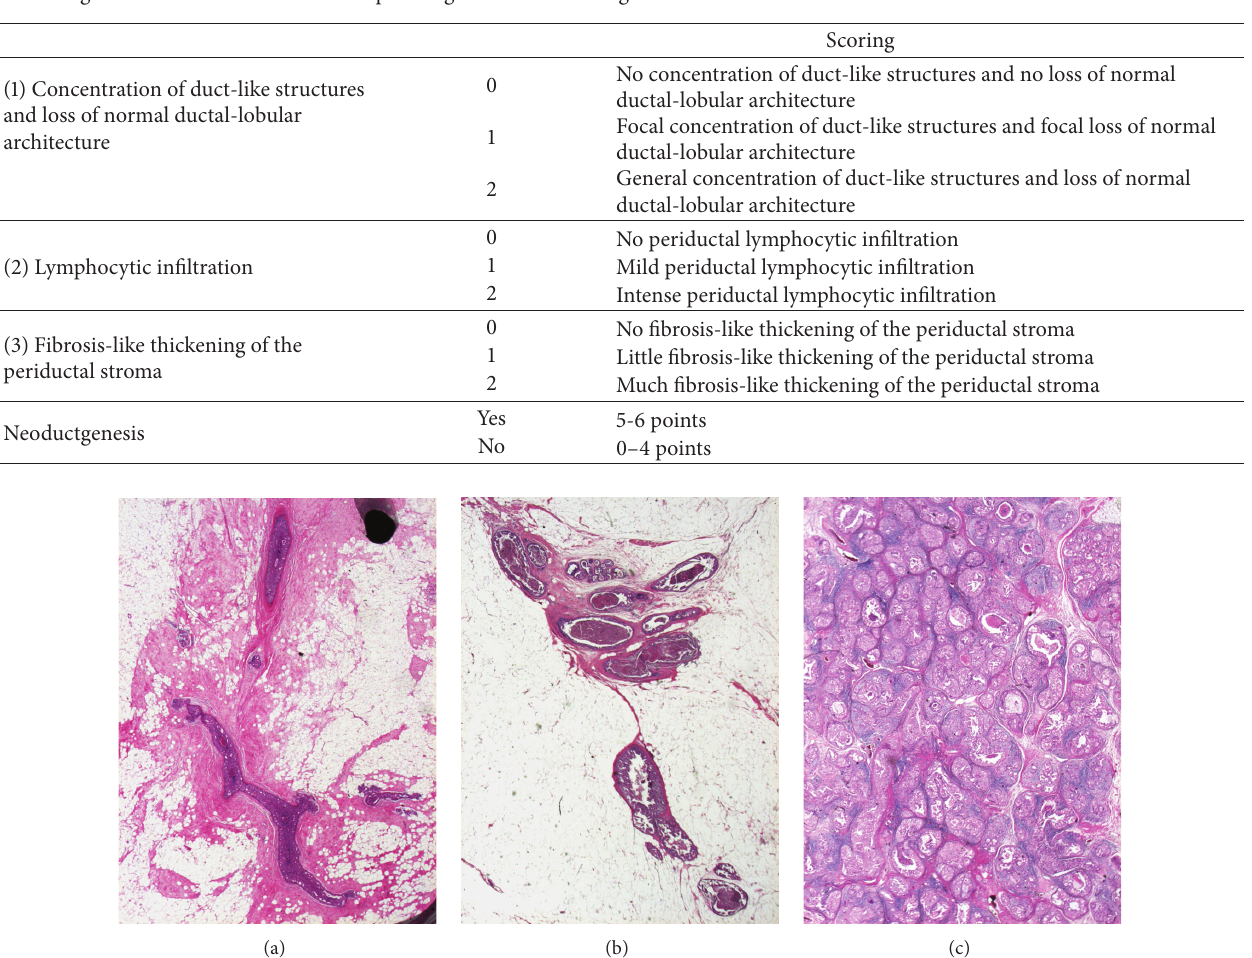
Table 1: Criteria for scoring the concentration of duct-like structures, lymphocytic infiltration, and periductal fibrosis. The classification of “neoductgenesis” was based on these histopathological criteria. See Figures 1–3.